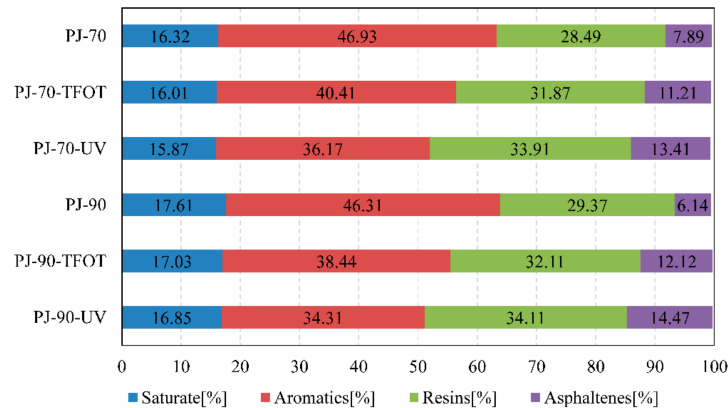
Figure 3. Compositions of bitumen before and after